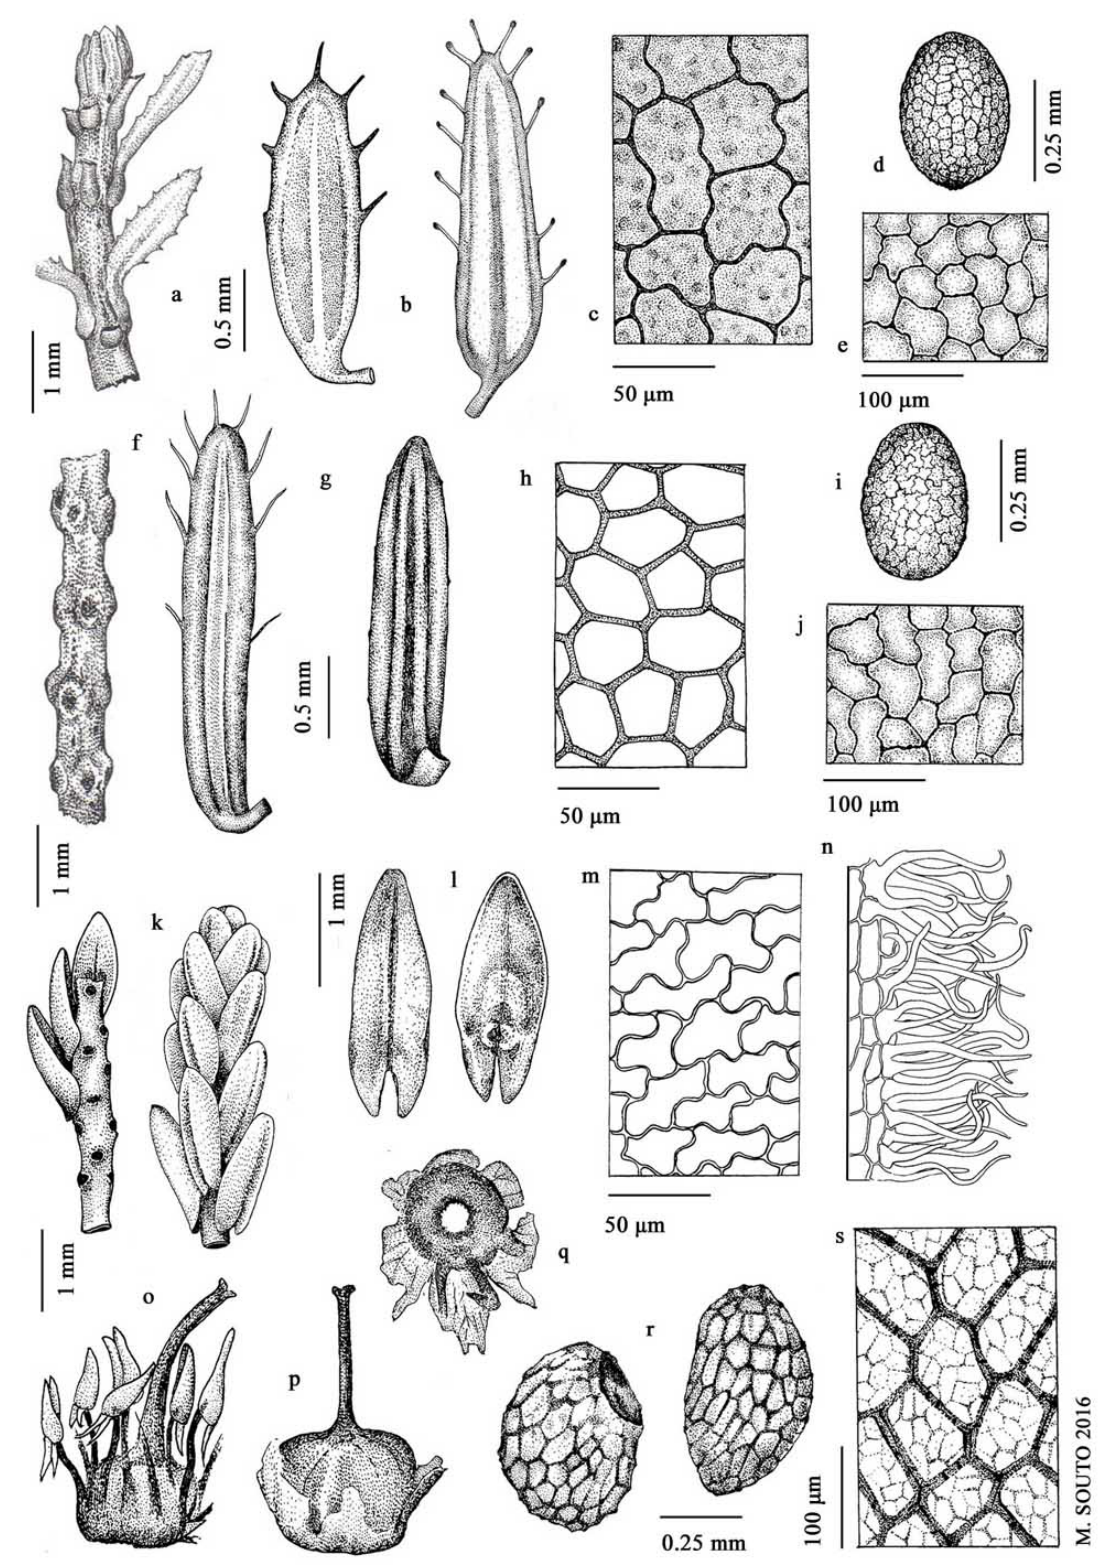
Figure A5. Erica mackaiana : a) fragment of twig with leaves; b) leaves; c) epidermal cells of adaxial leaf blade; d) seed; e) seed testa epidermal cells. Erica tetralix : f) twig fragment; g) leaves; h) epidermal cells of adaxial leaf blade; i) seed; j) seed testa epidermal cells. Calluna vulgaris : k) fragments of twigs with leaves; l) leaves; m) epidermal cells of adaxial leaf blade; n) trichomes of the abaxial leaf blade; o) flower remains; p) capsule with perianth remains; q) perianth remains; s) seed testa